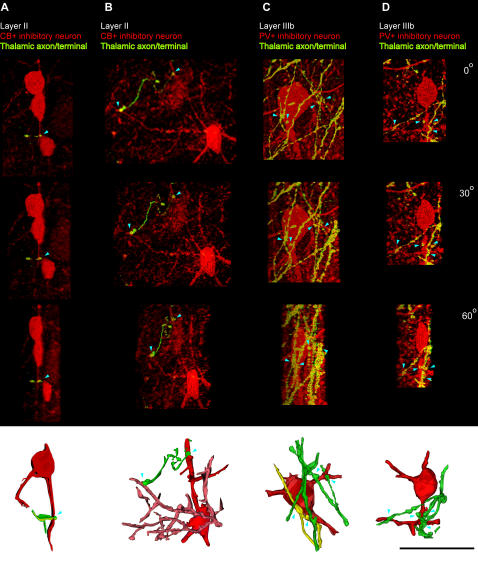
Appositions of laminar-specific thalamo-cortical terminals with local inhibitory neurons labeled with CB and PV in the prefrontal cortex.The first three images in each column are incrementally rotated by 30° around their Y axis, and the last row of renderings shows three-dimensional reconstructions of apposed neurons (red or pink) and fibers (green or yellow) in the images directly above. Columns A, B, Some thalamo-cortical terminals in layer II of area 32 (yellow) that are anterogradely labeled with green fluorescent tracer and also express CB (red) were closely apposed to CB+ local inhibitory neurons, likely forming synapses (blue arrowheads). Columns C, D, Some thalamo-cortical terminals in layer IIIb of area 9 (yellow) that are anterogradely labeled with green fluorescent tracer and also express PV (red), were closely apposed to local inhibitory neurons labeled for PV, and also form close appositions and possible synapses (blue arrowheads). Scale bar: 50 µm.